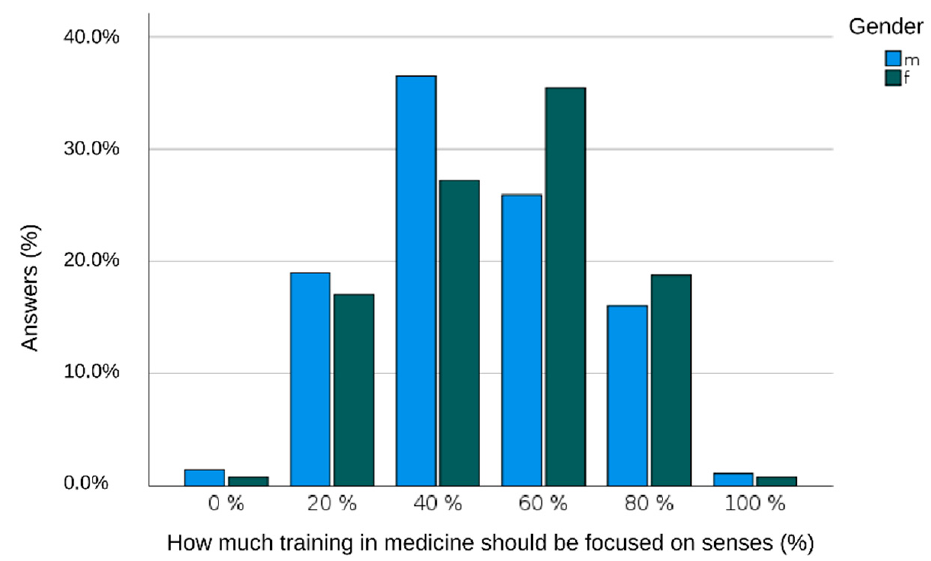
Figure 1. Male (m) students favor high-tech medical themes in the curriculum more than women do (f).